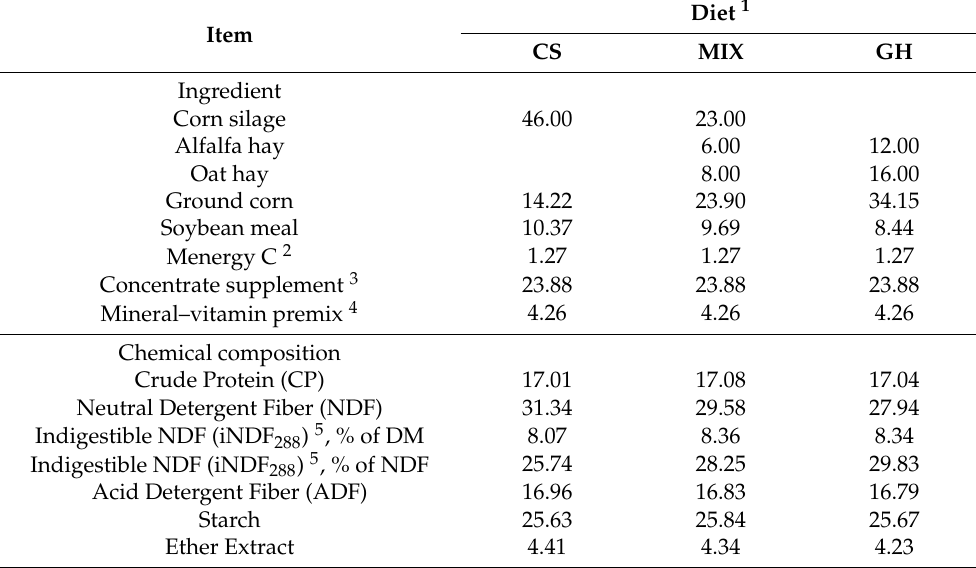
Table 1. Ingredients, chemical composition (% of DM unless otherwise noted), and fatty acid profile (% of total FA) of the experimental